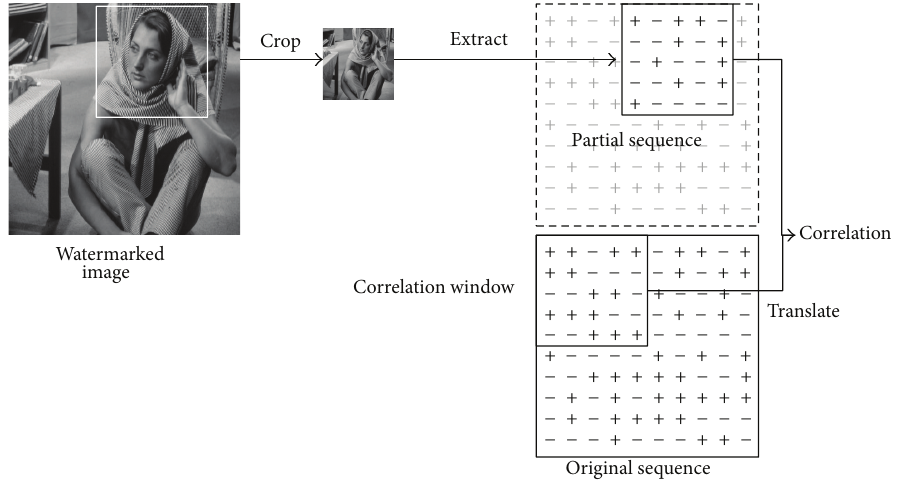
Figure 1: Cropping and